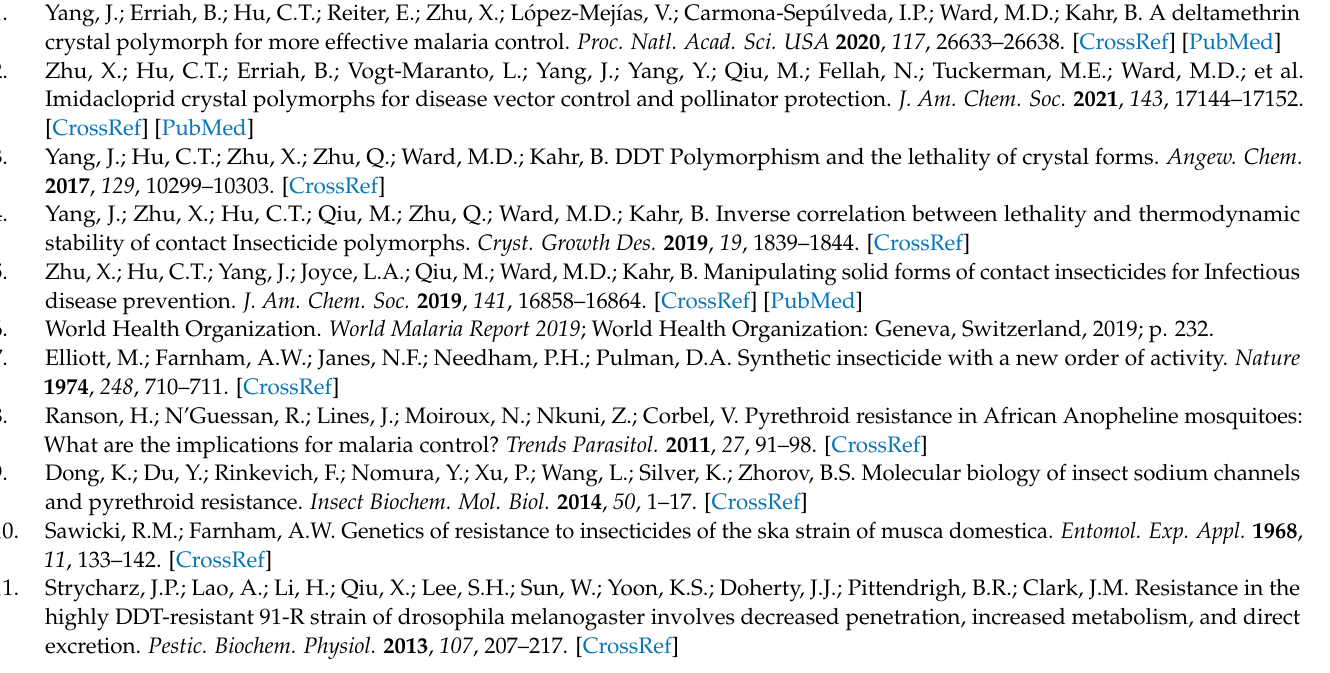
Figure S1: Heterogenous nucleation of λ -Cyhalothrin Form II on α -Cypermethrin crystals, Figure S2: Raman spectra of thiacloprid Form I and Form II, Figure S3: Single-crystal images with Miller